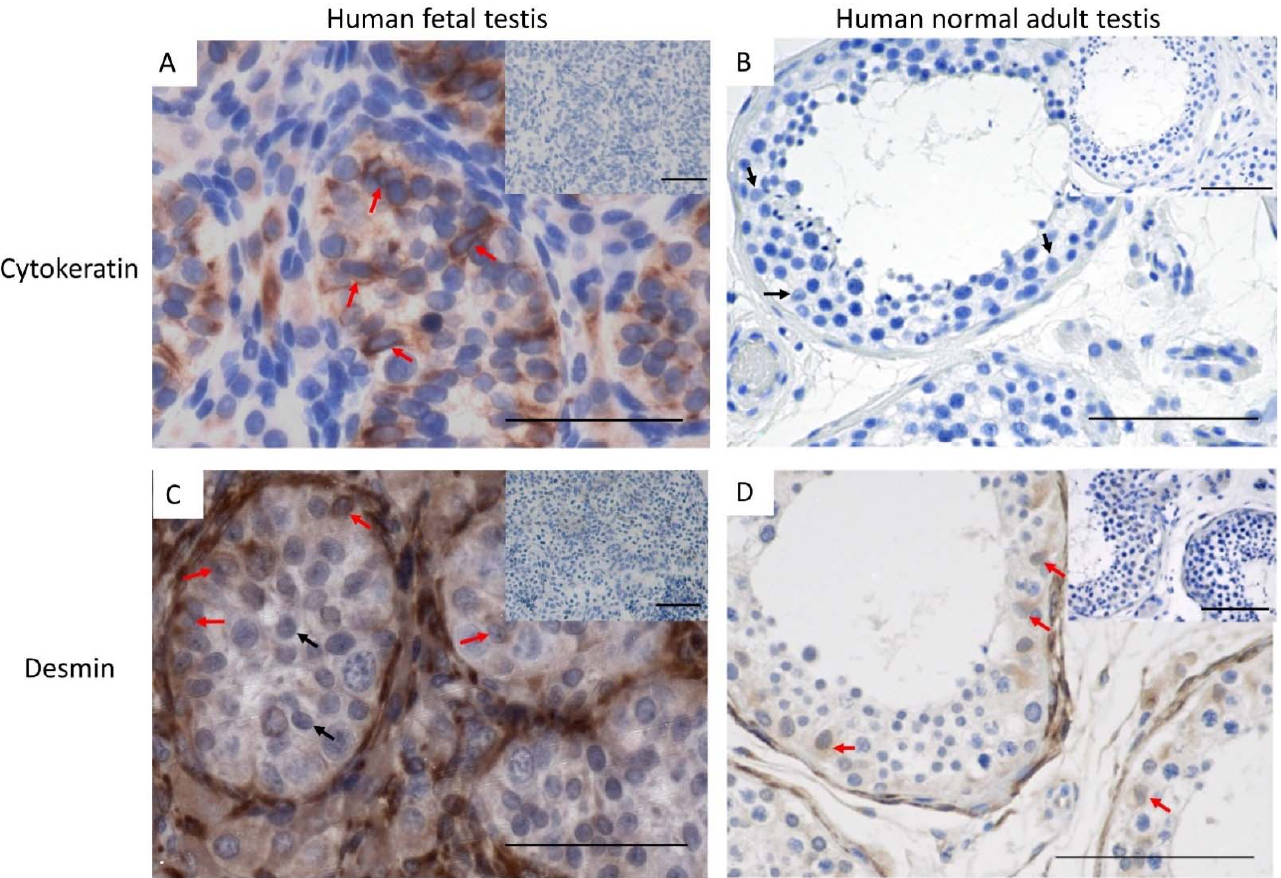
Figure 3. Cytokeratin expression in ( A ) human fetal testis (20 GW) and ( B ) normal adult testis (n = 3). red arrows: cytokeratin + Sertoli cells, black arrows: cytokeratin − Sertoli cells. ( C ) Desmin expression in normal fetal testis (17 GW) and ( D ) normal adult testis (n = 6). Scalebars represent 50 µ M ( A , C ) and 100 μ M ( B , D ), red arrows: desmin + Sertoli cells, black arrows: desmin − Sertoli cells, insets: negative controls.